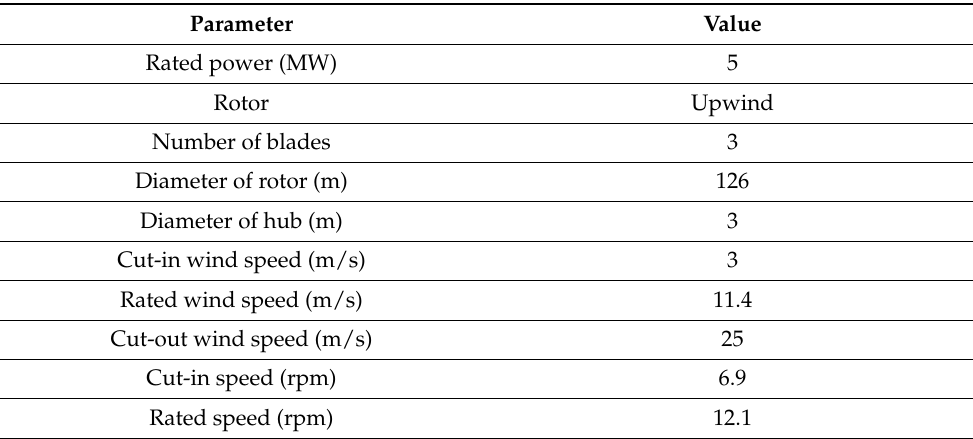
Table 1. NREL 5 MW wind turbine